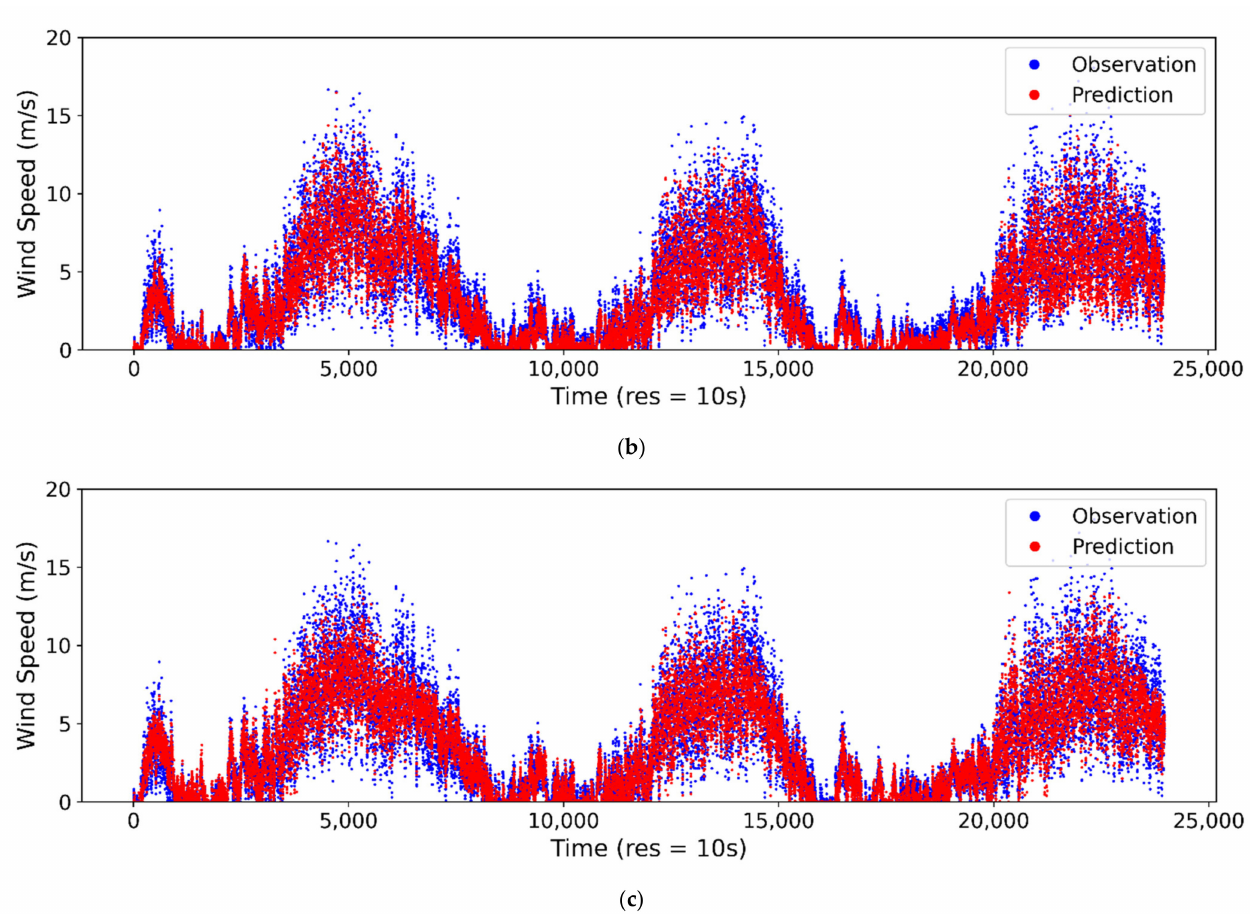
Figure 6. Comparison of predicted/estimated and observed wind speed at 10-s sampling interval for ( a ) ANN, ( b ) SVM and ( c )